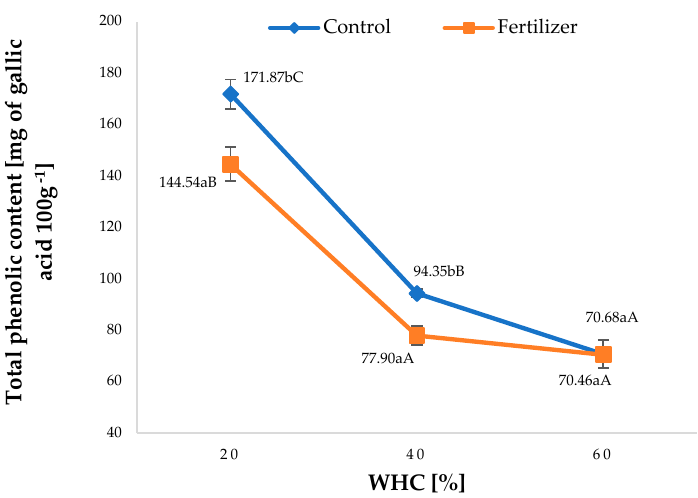
Figure 5. Total polyphenolic content in maize leaves in relation to whether fertilizer was applied and to WHC [%] ( n = 20). Significant differences between the results for enhanced and non-enhanced plants growing in soils with the specific water holding capacity are marked with small letters according to the t -Test ( p < 0.05). Significant differences in the results for the various water holding capacity values are marked with capital letters according to the Tukey’s test (p < 0.05).